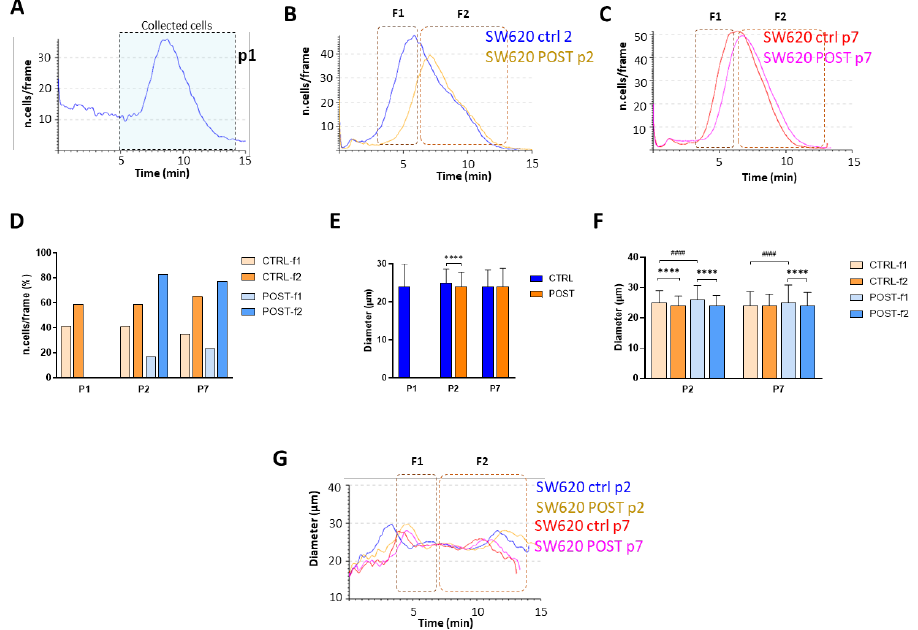
Figure 2. Celector analysis for SW620 cells. Representative fractogram of SW620 cells at passage 1 in culture and collection time of the main population ( A ). The cell profile was monitored after in vitro culture for the CTRL cell population and for the collected cells, post-culture. After every enzymatic detachment, cells were analyzed for both conditions, and at p2, CTRL cells exit the channel earlier than POST cells ( B ), while at passage 7, both conditions showed similar elution times and fractogram profiles ( C ). The distribution of the percentage of cells during the analysis showed a difference in behavior during culture conditions, from a mostly homogenous situation to a higher presence of cells in F2 for the POST-derived cells ( D ). The cell diameter was measured, and CTRL cells showed a higher dimension at p2, and POST cells a stable dimension over the passages ( E ). When the population was decomposed into 2 fractions, F1 and F2, the resulting F1 cells are bigger than F2 cells at p2 and p7 ( F ). The representation of the average diameter as a function of time showed similar dimensions between the two conditions ( G ). Statistical analysis was performed using the 2way ANOVA test and mean and standard deviation were graphed (**** and #### p < 0.0001).